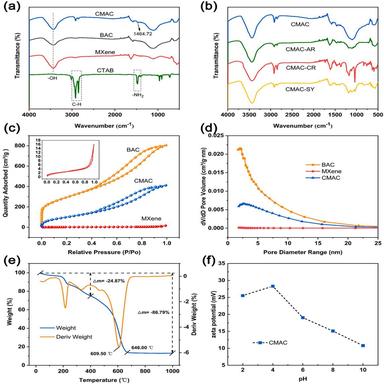
FTIR spectra of (a) CMAC, BAC, MXene, CTAB and (b) CMAC before and after the AR, CR and SY adsorption. (c) N2 adsorption/desorption isotherms and (d) pore–size distribution of CMAC, BAC and MXene. (e) TG and DTG curves of CMAC. (f) Zeta potentials of CMAC at different pH conditions.